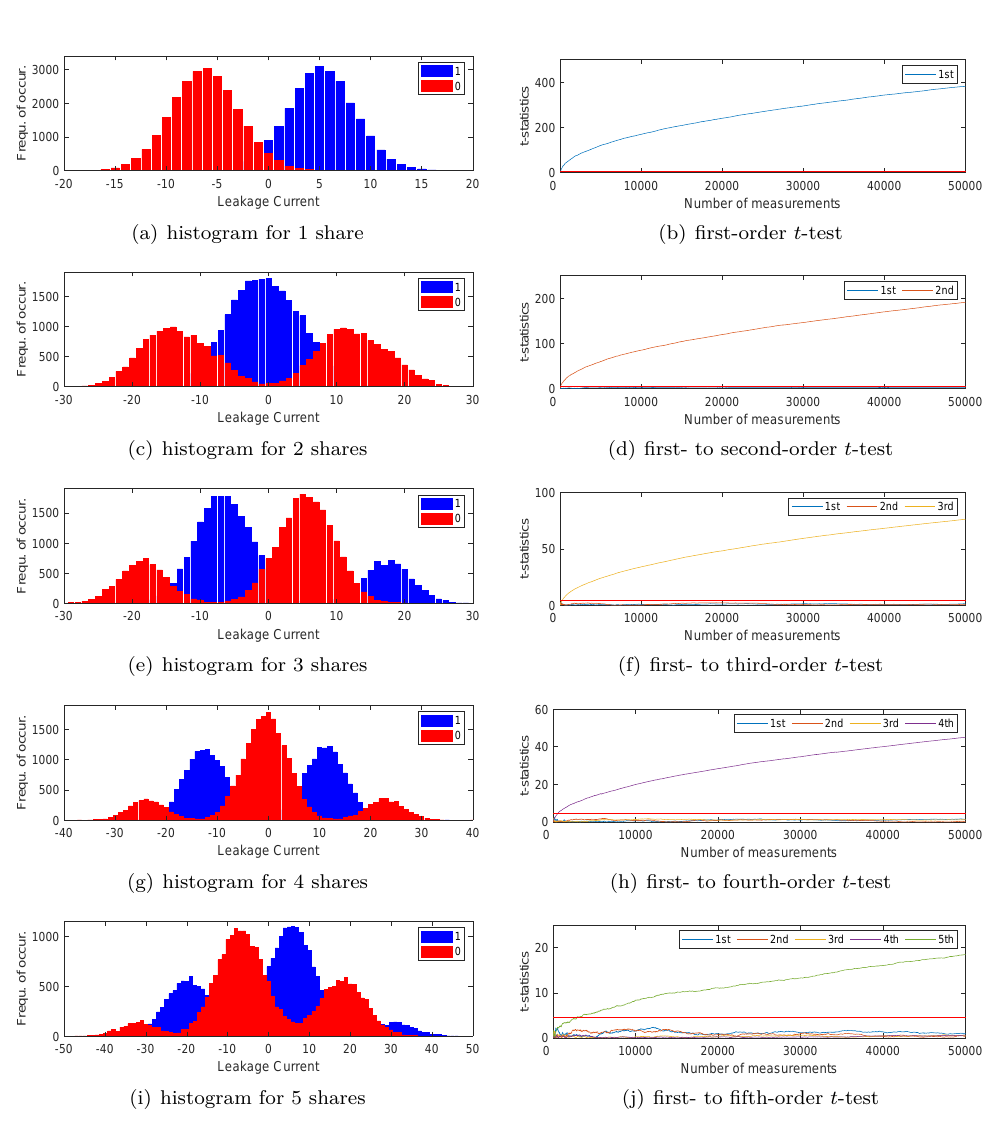
Figure 8: Histograms and (higher-order) t -test results for 50,000 static power measurements of 1-bit of information shared among 1, 2, ..., 5 (top to bottom) high-fanout register bits in 65 nm CMOS technology, recorded at 90 ◦ C and 1 . 6